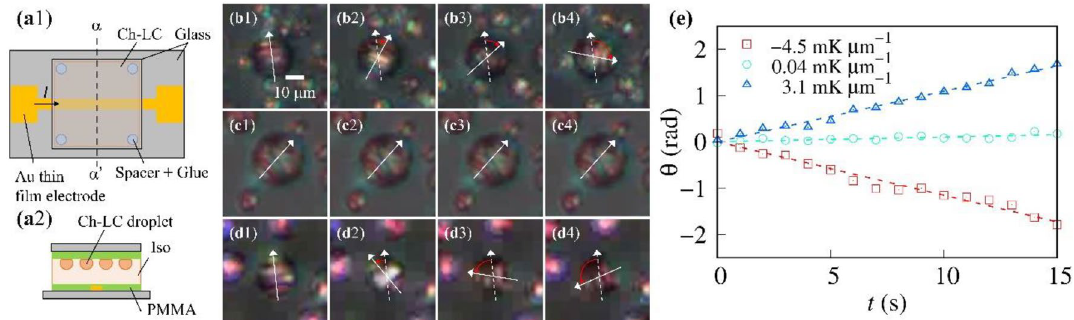
Figure 1. Ch-LC droplets subjected to a uniform temperature gradient. ( a1 ) A schematic top-view image of the LC cell. We patterned an Au thin-film electrode on the lower glass substrate and introduced Ch-LCs between the upper and lower substrates. The spacing of the glass substrates was adjusted to 40 µm by bead spacers. ( a2 ) Cross-section view (α-α ′ ) of the LC cell. We used polymethyl methacrylate (PMMA) as an alignment film in the Ch-LC sample. Polarized microscopic images of Ch-LC droplets are shown for uniform temperature gradient values of ( b ) ∇ T = − 4.5 mK/µm (Supplementary movie 1), ( c ) ∇ T = 0.01 mK/µm (Supplementary movie 2), and ( d ) ∇ T = 3.1 mK/µm (Supplementary movie 3). White arrows and white dashed arrows indicate the direction of the helical axis of the director configuration and the initial direction of the axis, respectively. Snapshots were collected every 5 s. ( e ) The time evolution of θ. The dashed lines are best-fit lines obtained using linear